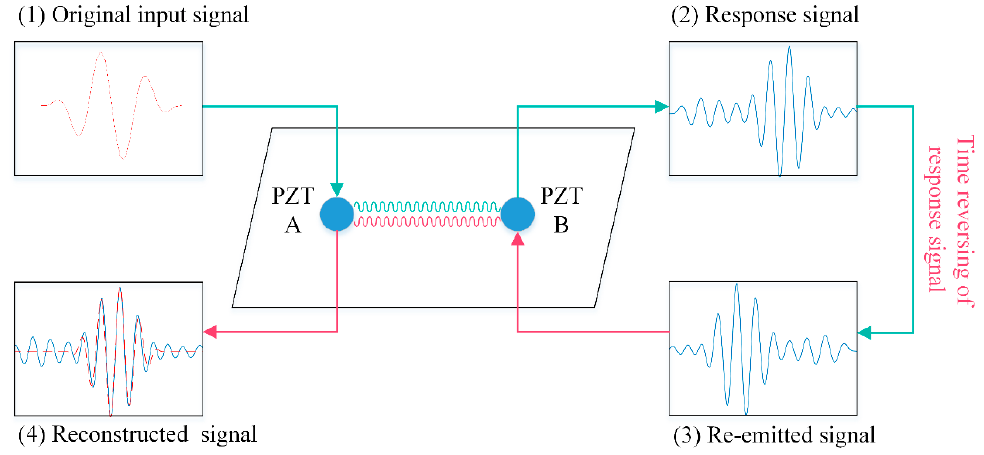
Figure 1. Schematic diagram of the time reversal process (TRP). PZT: Piezoelectric.